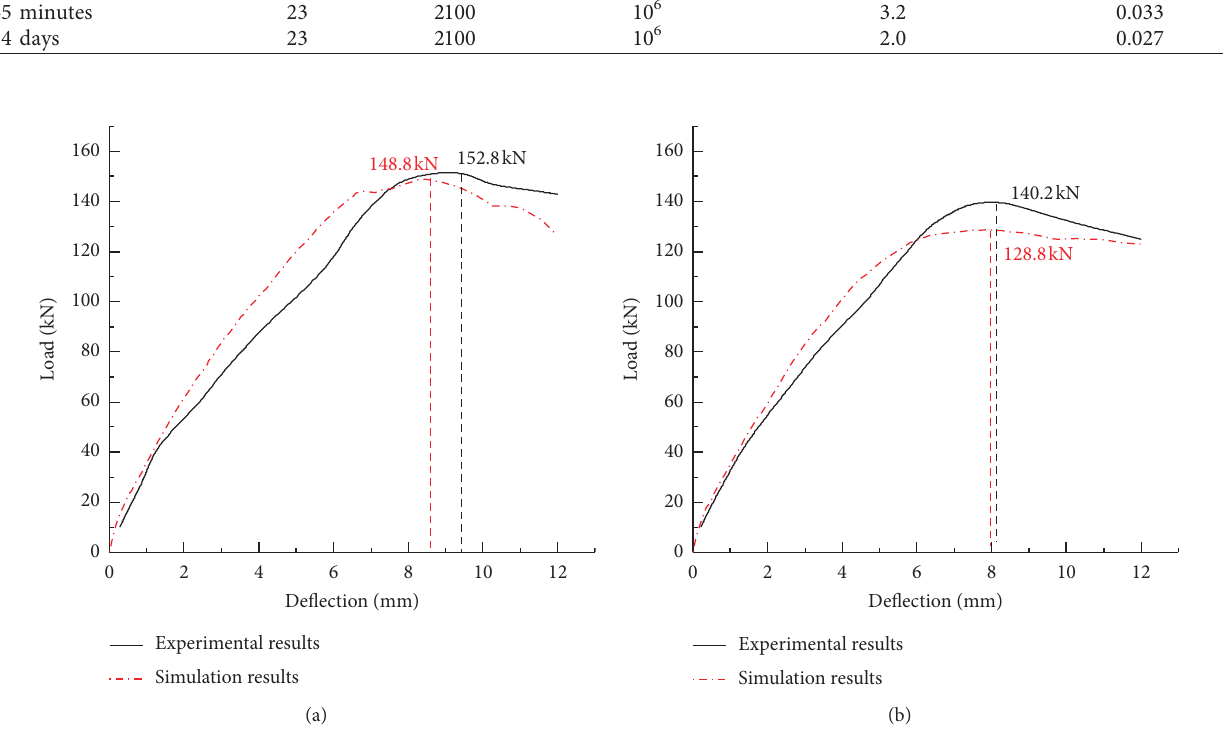
Figure 2: Load-deflection relationship of B1-1 and B1-2. (a) B1-1. (b)